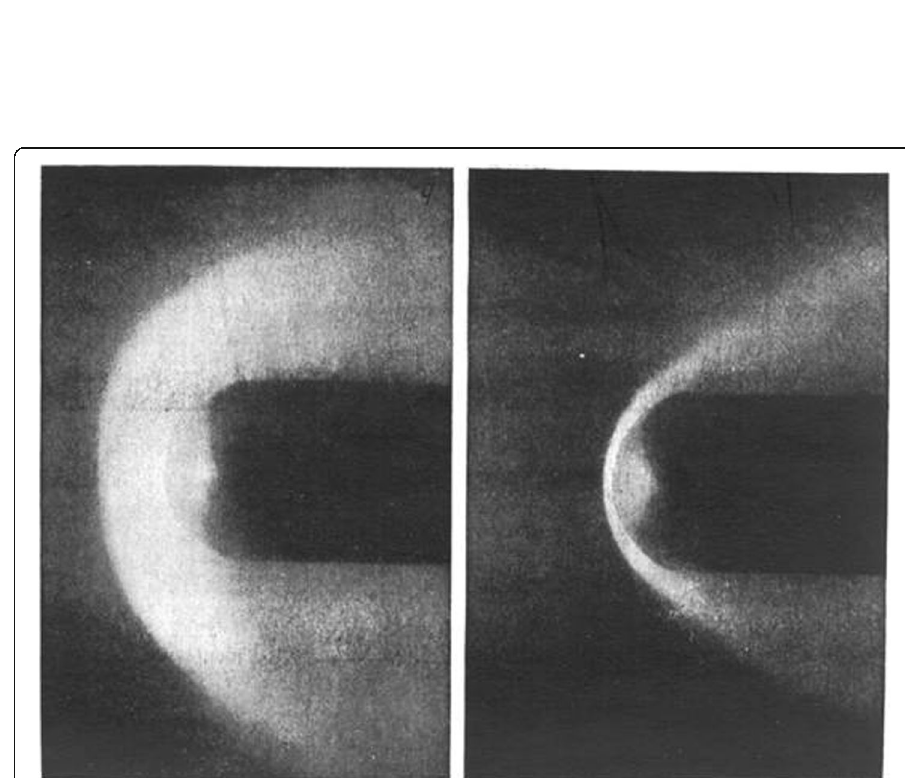
Fig. 11 Magnetic field effect on bow shock standoff